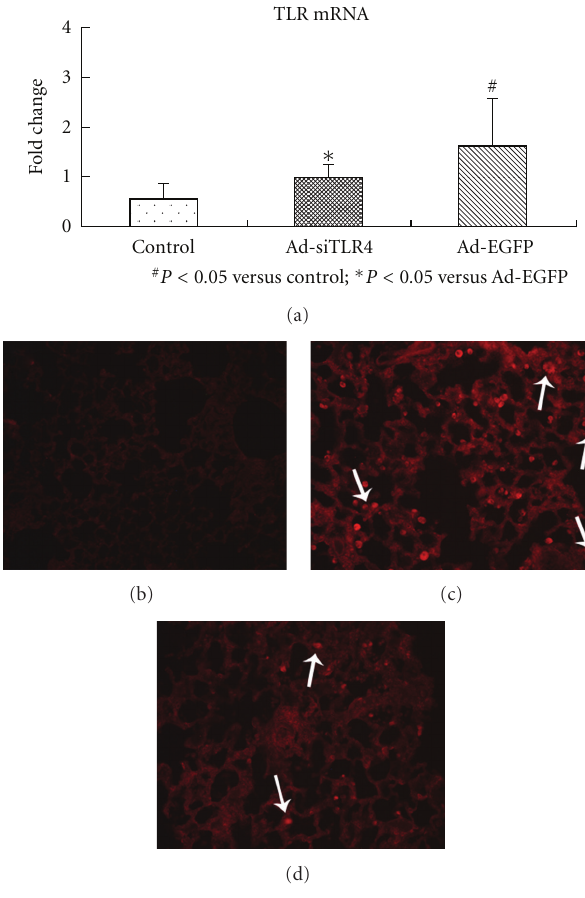
Figure 2: (a) mRNA level of TLR4 in the lung in control group, Ad-EGFP group, Ad-siTLR4 group following LPS treatment. (b), (c), and (d) represent TLR4 protein expression in the lung tissues in control group, Ad-EGFP group, and Ad-siTLR4 group, respectively. ∗ P < 0 . 05 versus Ad-EGFP group, # P < 0 . 05 versus control group. White arrow shows the positive